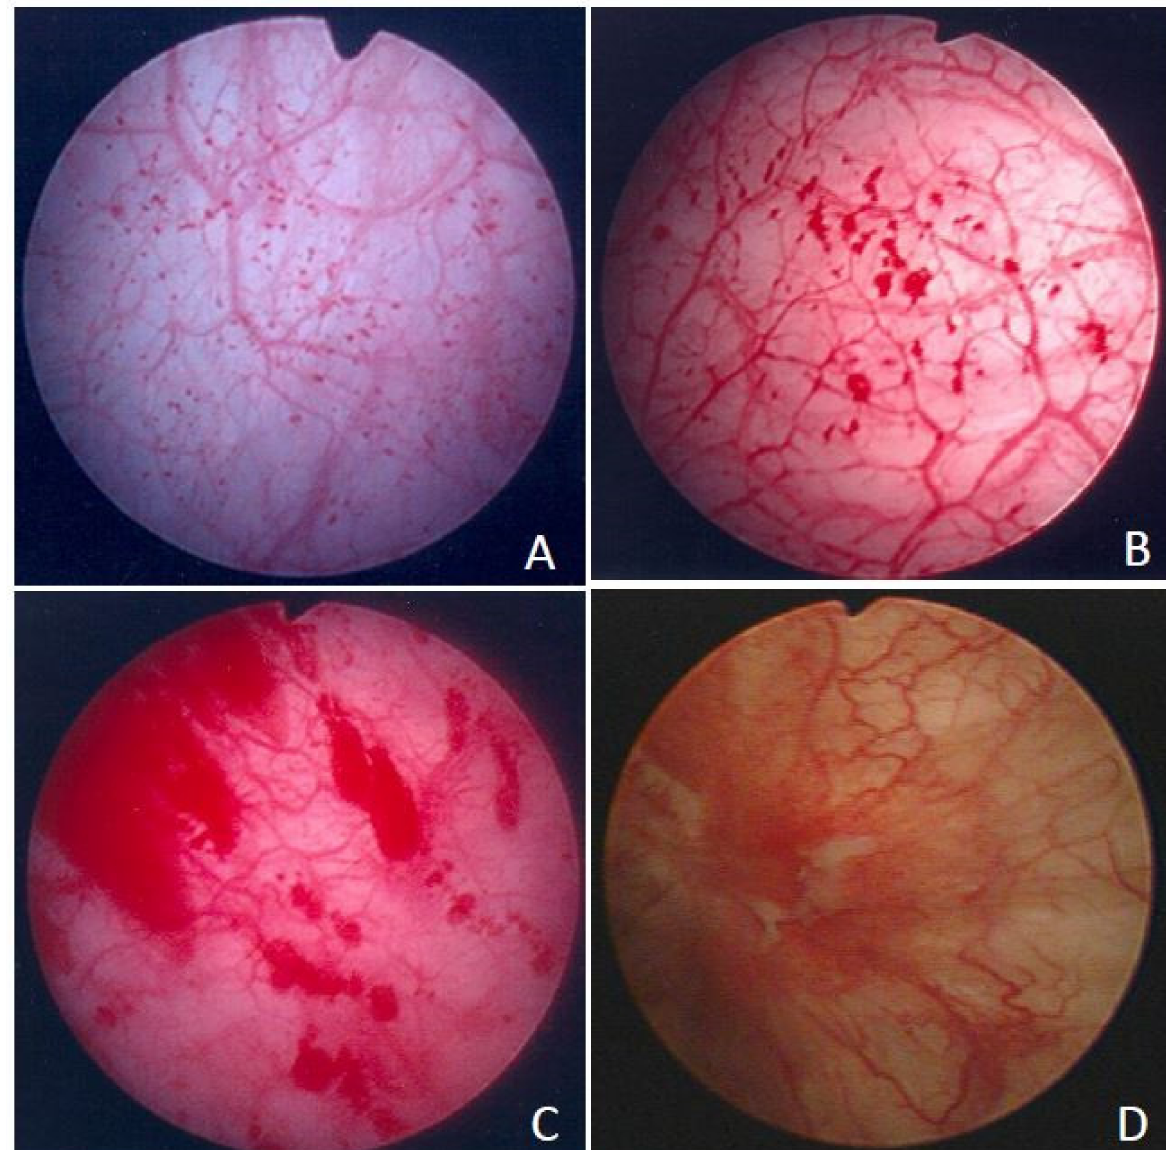
Figure 1. Cystoscopic findings of patients with interstitial cystitis/bladder pain syndrome. ( A ) Grade 0–1 glomerulation with petechiae that developed after hydrodistention, ( B ) grade 2 glomerulation with diffused hemorrhage, ( C ) grade 3 glomerulation with splotch hemorrhage and occasional mucosal fissure, and ( D ) Hunner’s lesion, which can be commonly observed without anesthesia or hydrodistention. The arrows indicate the top of cystoscopic